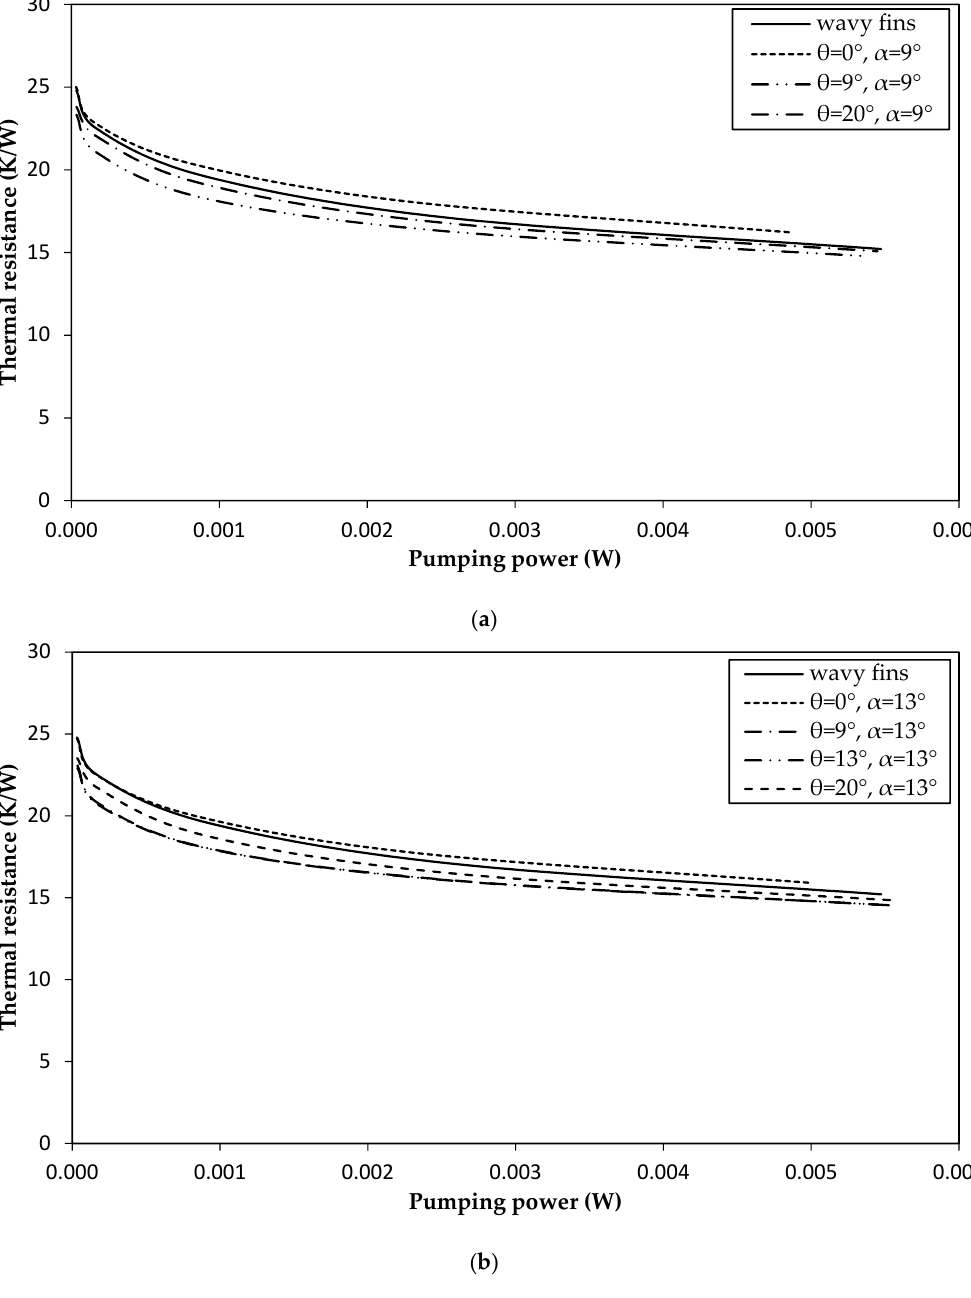
Figure 9. Thermal resistance vs. pumping power in combination of louver, flat and wavy fins: ( a ) W = 8 mm, n = 2, and α = 9°; ( b ) W = 8 mm, n = 2, and α = 13°.